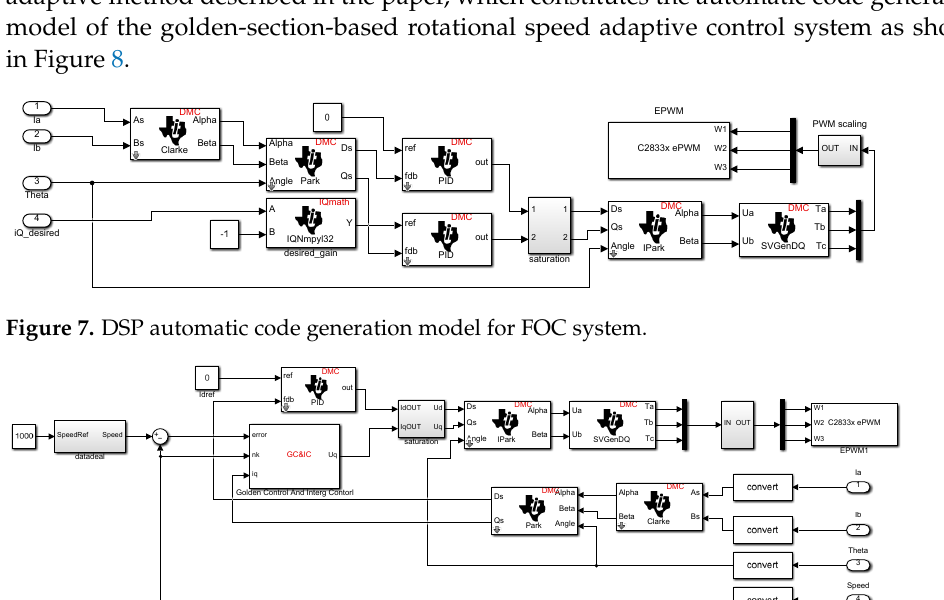
Figure 8. Golden-section speed adaptive code generation model.